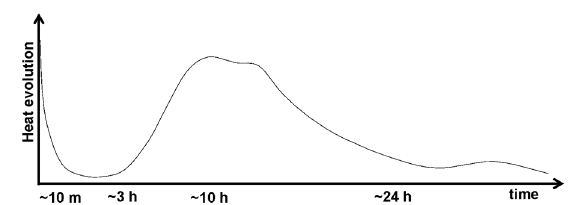
Figure 5. Typical heat of hydration curve for a Portland cement at 20°C.